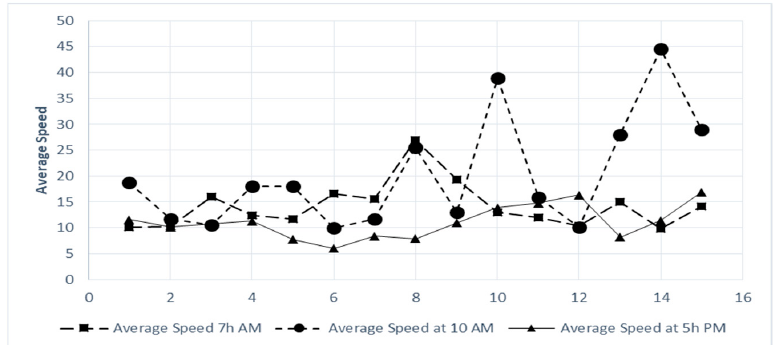
Figure 21. Comparison of Average Speed in Town.